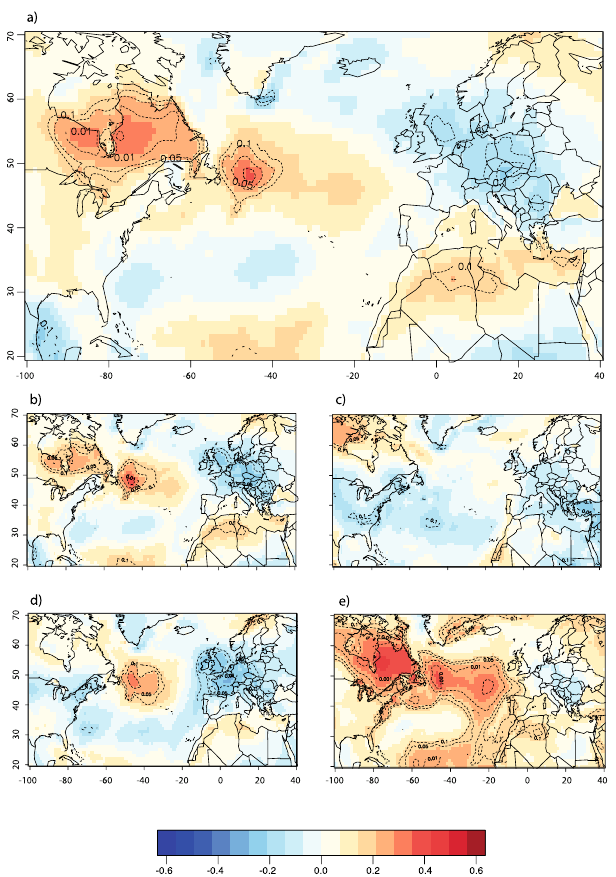
Figure 4. The regional growing season (May-August) surface air temperature signal captured by MW ( a ), EW W ( b ), LW W ( c ), EW D ( d ) and LW D ( e ). Map shows Pearson correlation coefficients between tree ring based index (averaged across all 48 sites in Quebec-Labrador) and surface air temperatures across the North Atlantic basin. Dotted lines represent p values for these correlations, after taking into account serial autocorrelation 62 . Maps generated in R 63